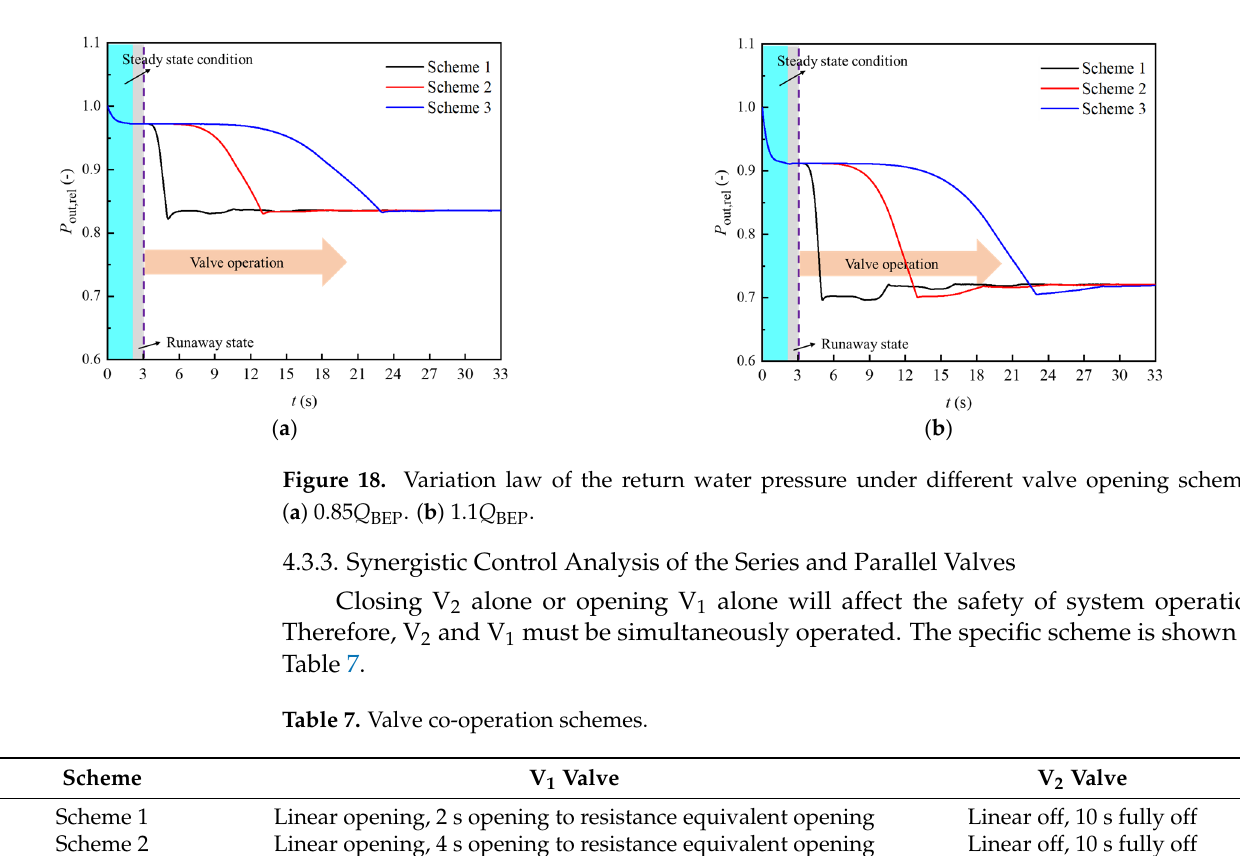
Table 7. Valve co-operation schemes.